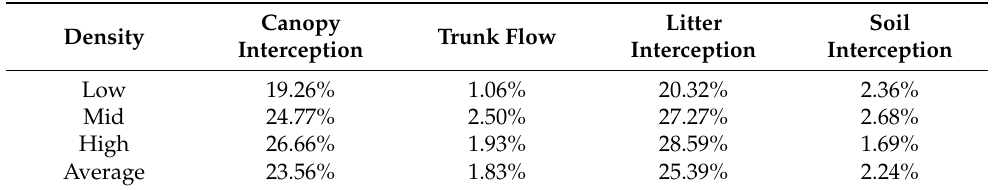
Table 4. Water retention capacity at different levels of Pinus massoniana plantations with different densities.